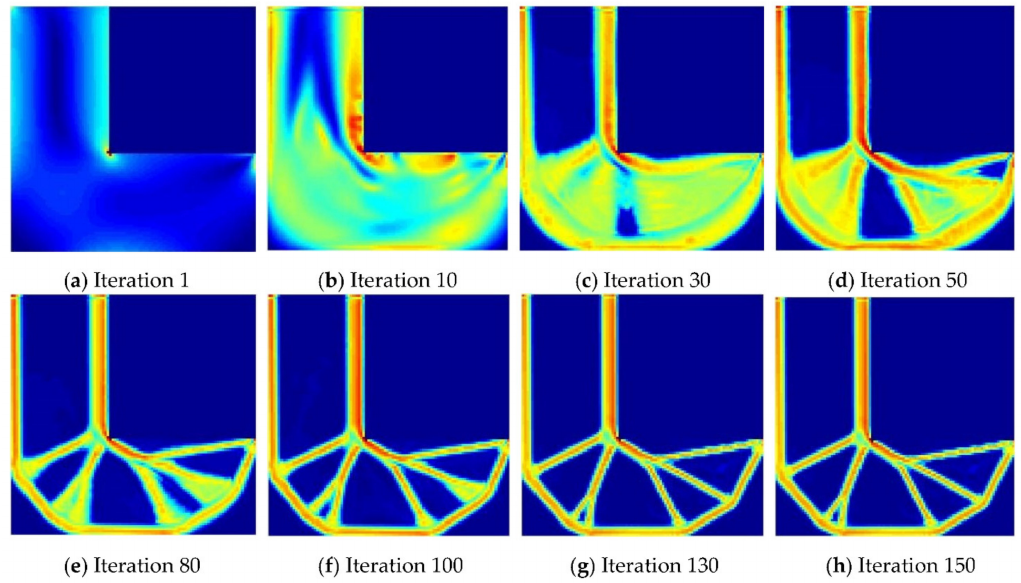
Figure 5. Structural evolution for deterministic topology optimization with stress distribution ( a – h ).